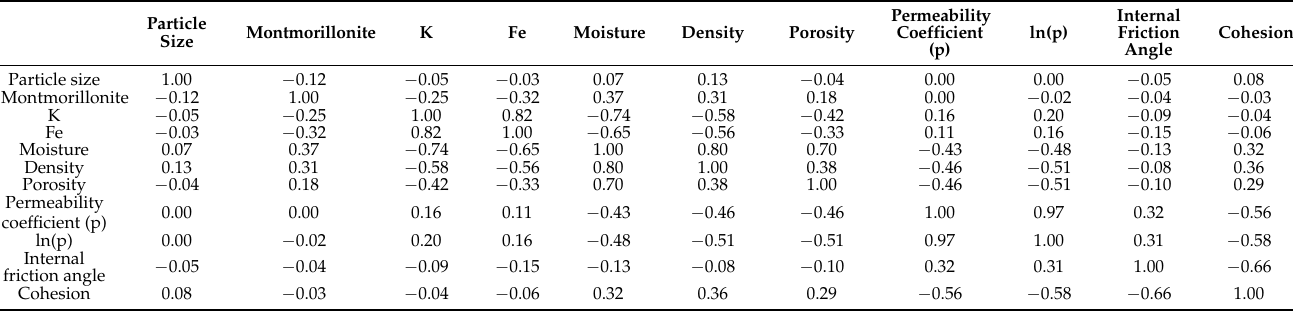
Table 1. Table of correlation